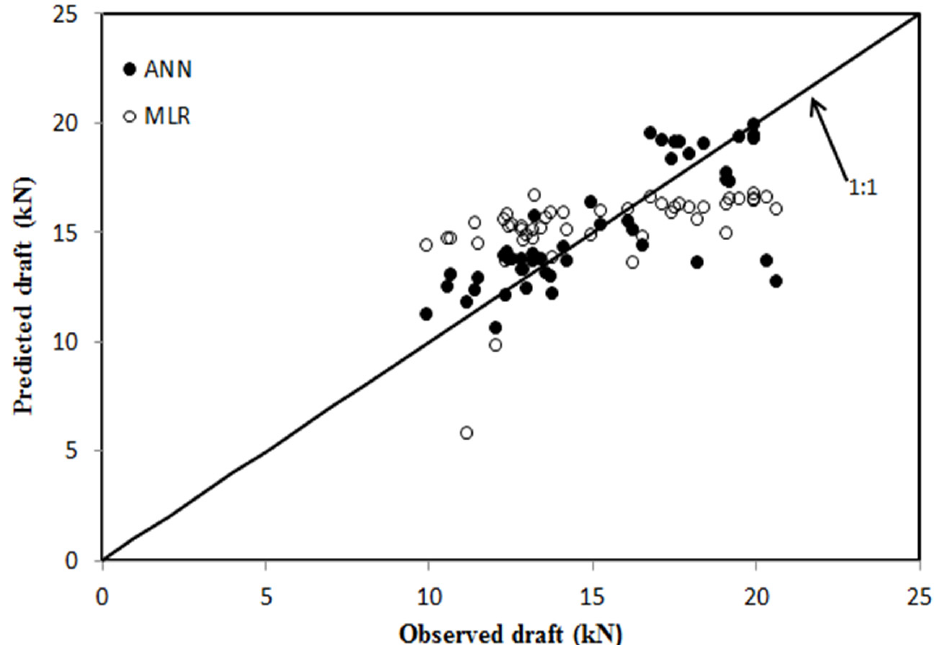
Figure 5. Correlation between the observed and predicted values for the draft of the ANN and MLR models in the case of the testing dataset.